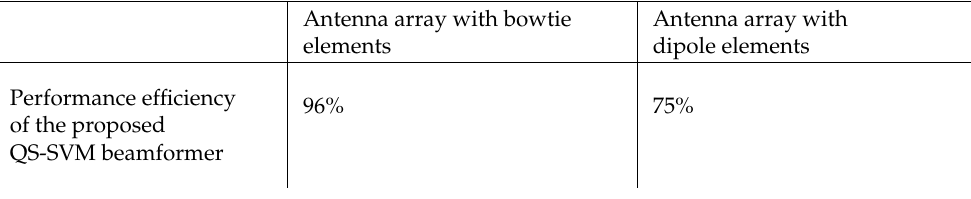
Table 2. A comparison between the classification performance of the QS-SVM beamformer using the hybrid antenna array with bowtie elements, Figure 1, and its geometrical counterpart with dipole elements. The hybrid array antennas have been demonstrated in